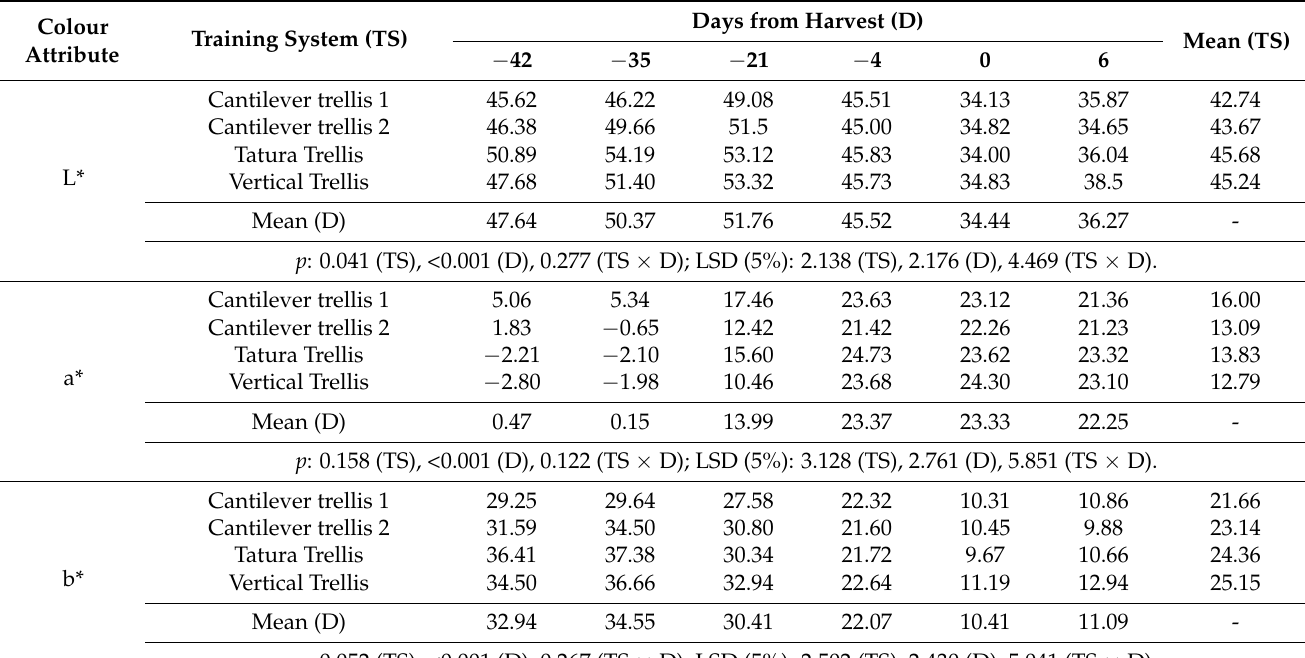
Table 5. Skin colour attributes of ‘Majestic Pearl’ nectarines subjected to different training systems. Means, ANOVAs’ p -values and Fisher Least Significant Differences (LSD, 5%)